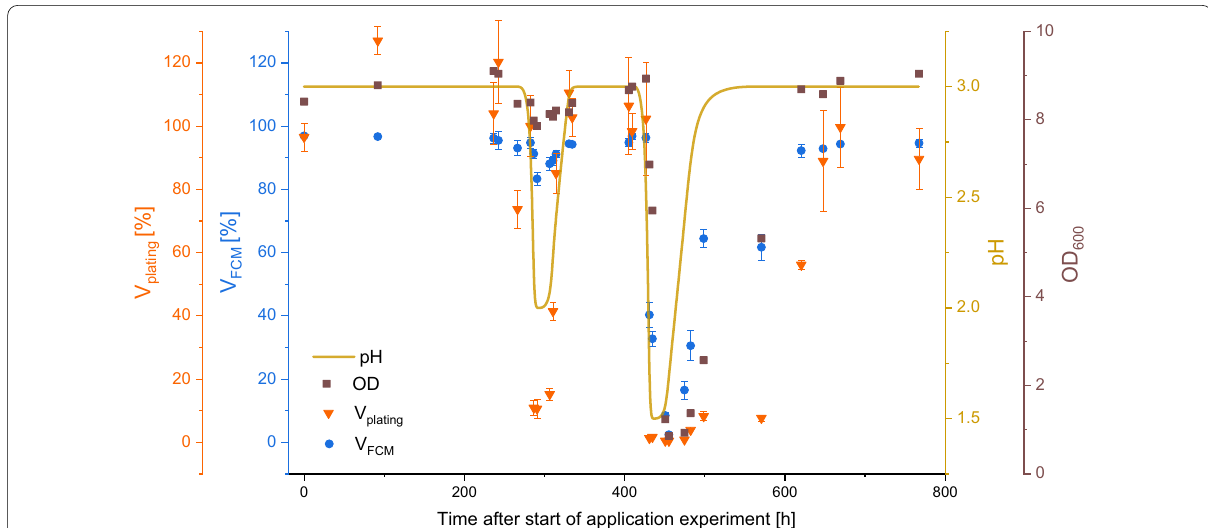
Fig. 3 Comparison of viability measurements of Sulfolobus acidocaldarius in response to the shift in pH value, observed over time [h]. The viability was determined by flow cytometry (V FCM [%]) and by plating assay (V plating [%]). Both pH shifts from 3.0 to 2.0 and to 1.5, respectively caused a drop in both viability-determining methods as well as in OD 600 . In this case, V plating measured at the beginning of the experiment was set to 100%, and for determining V plating [%], the CFUs of each sample were then divided by this initial value